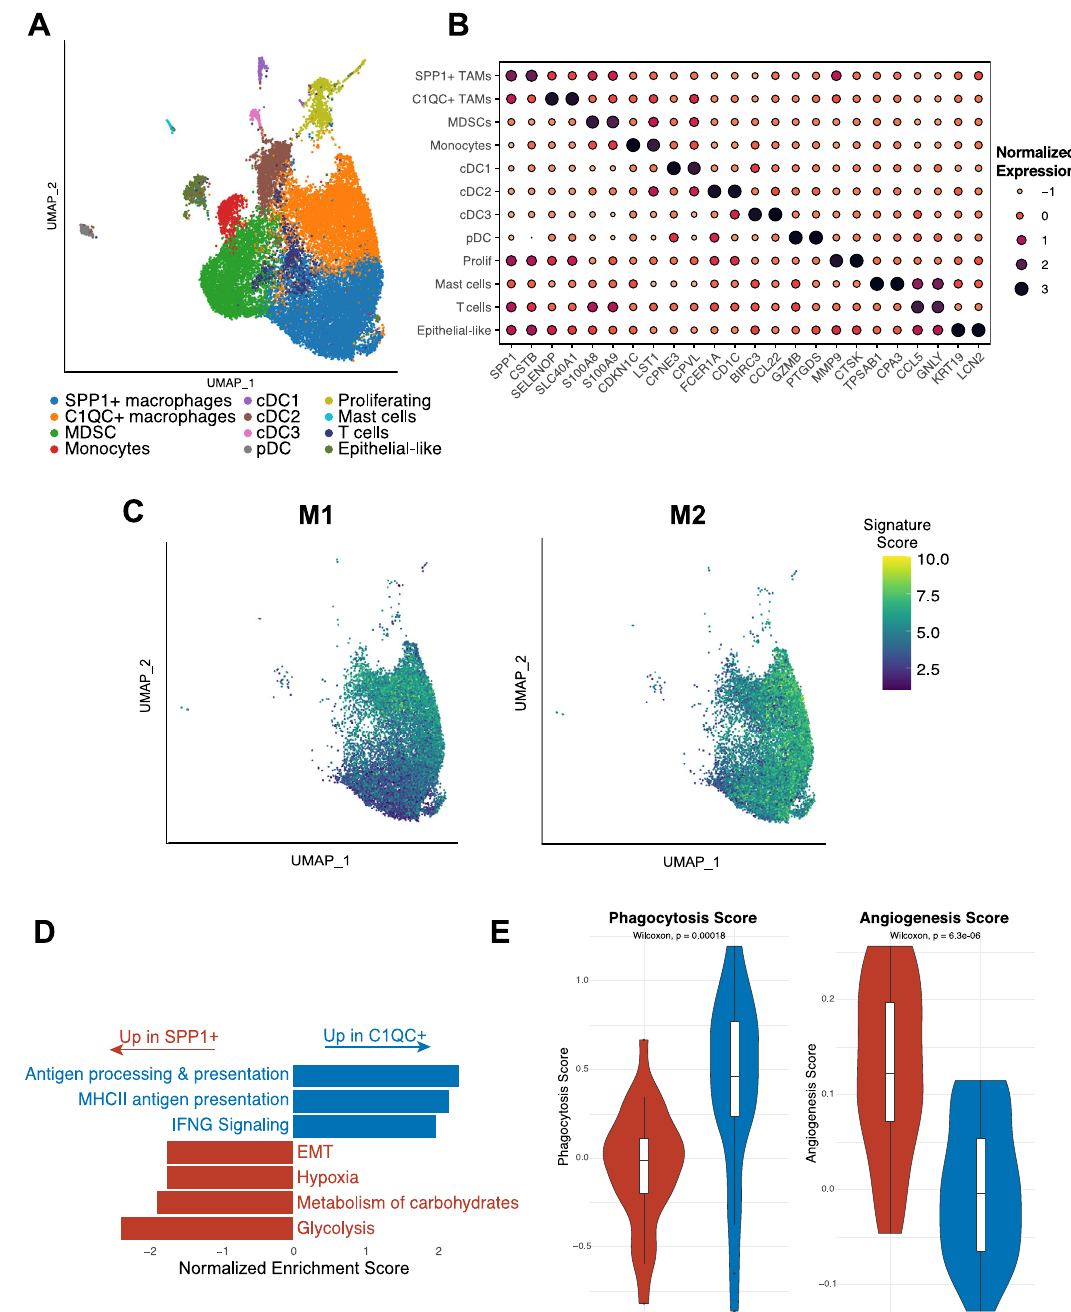
Fig. 5 | C1QC +and SPP 1 +TAMs comprise two distinct subpopulations within the myeloid cell compartment. A UMAP overview of the myeloid compartment. DC dendriticcell,MDSCmyeloid-derived suppressor cell,UMAPuniform manifold approximation and projection. B For each myeloid cluster, the two genes most differentially expressed between that cluster and the rest of the myeloid com- partment. TAM, tumor-associated macrophages. C M1 (left) and M2 (right) polar- izationsignaturesinthe macrophage populations. D Selectedgenesetenrichment